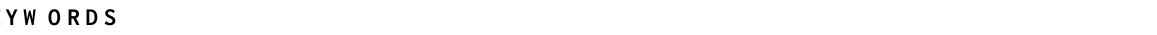
(PCs vs SDs) used on OHISB. The study indicates that the device used for online health information search plays an important role in shaping how health information searches by consumers and patients are